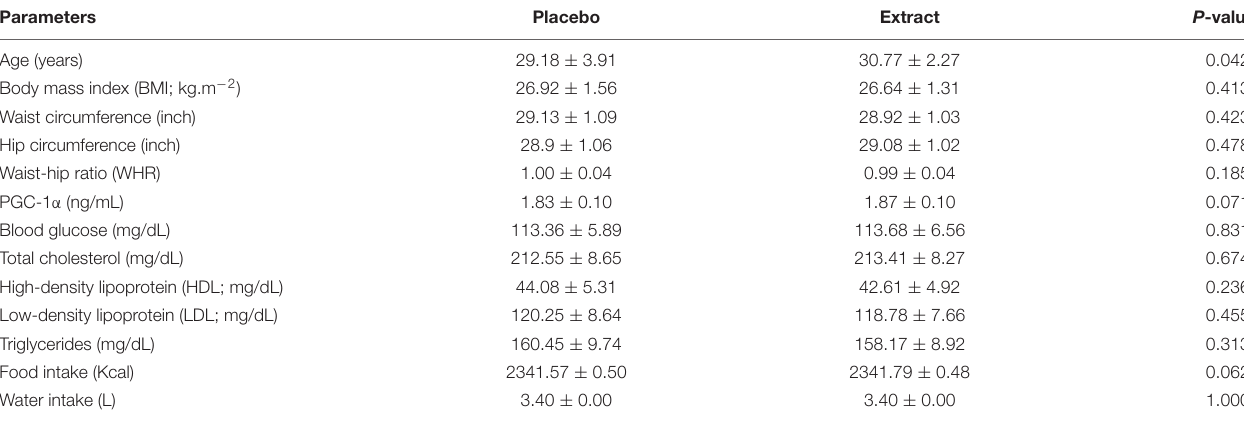
TABLE 5 | Characteristics of the participants on the baseline (0 week).